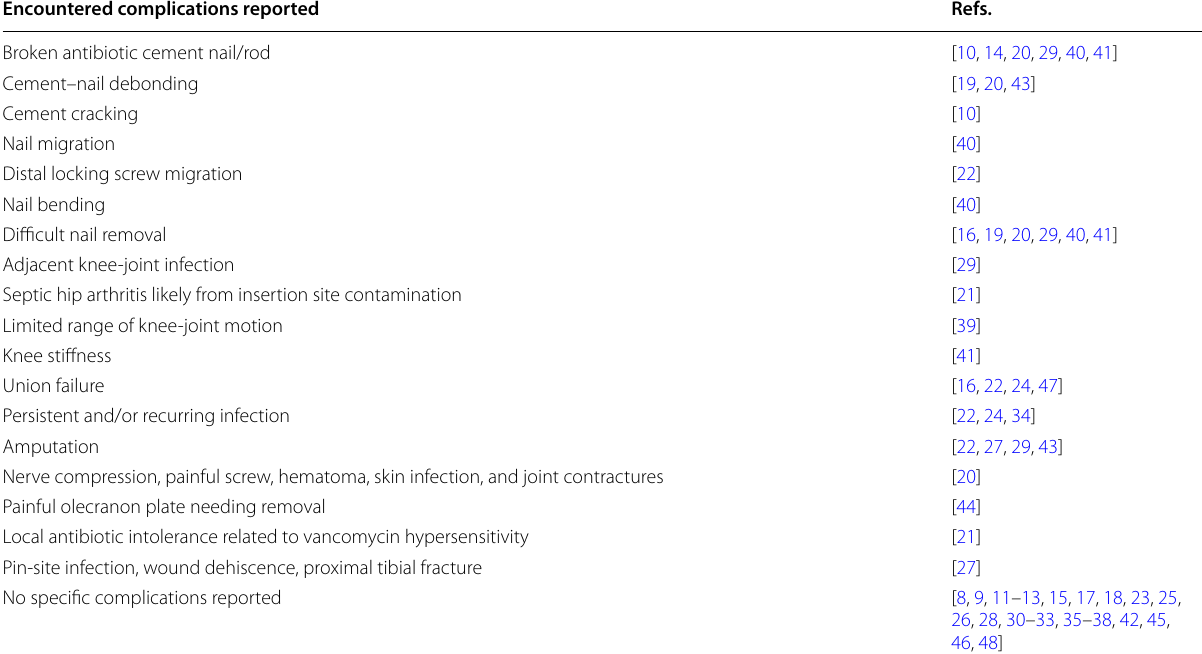
Table 5 Reported molding techniques outlined in detail Application and molding techniques of coating (digital, manual, device assisted) Refs.